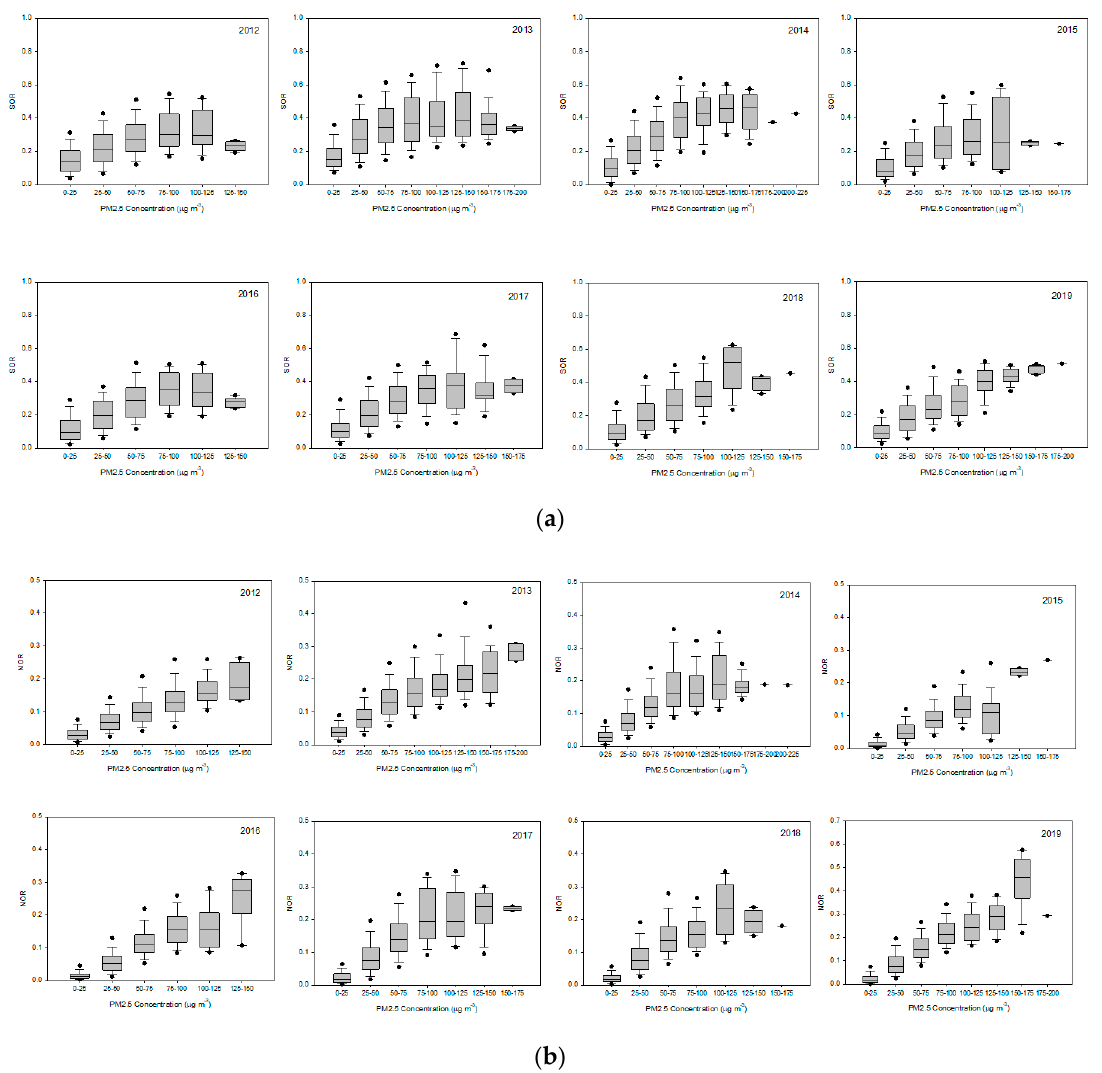
Figure 9. Changes in the SOR and NOR according to PM2.5 concentration in Seoul: ( a ) SOR; ( b )